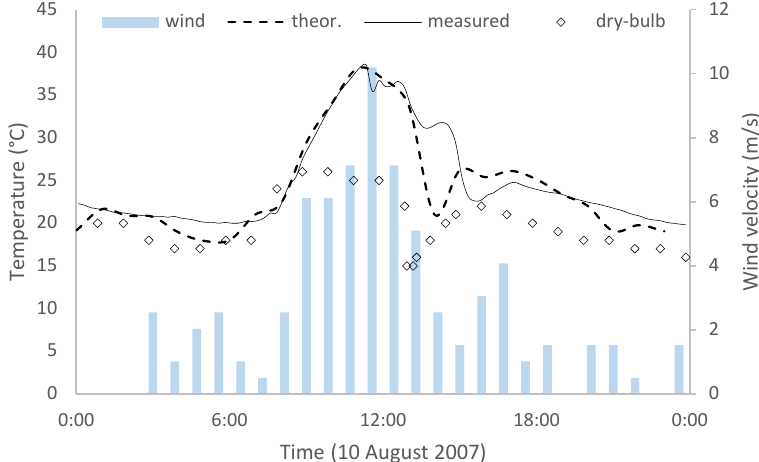
Figure 3. Comparison between the theoretical temperatures on the external surface and in situ mea- surements.